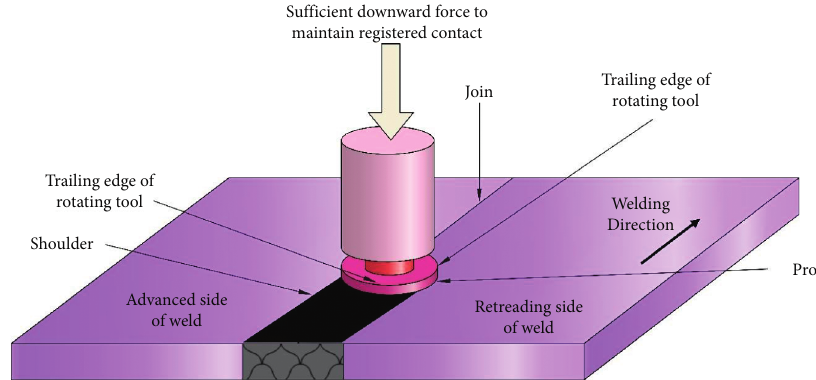
Figure 1: Schematic Diagram of Friction stir welding. Table 1: The values and levels of each of the four performance characteristics.